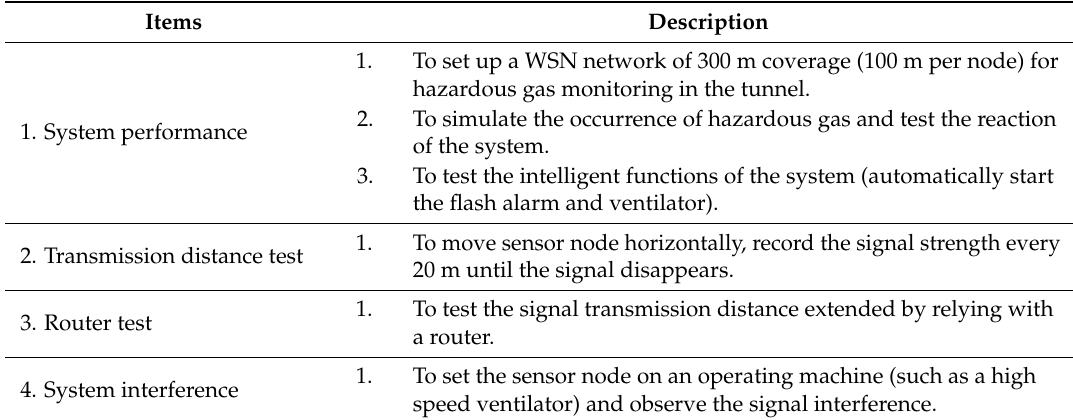
Table 4. The experiment item in tunnel.